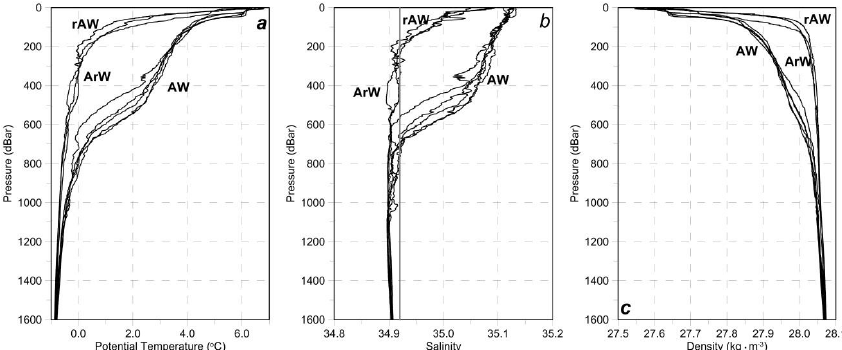
Figure 5. Profiles of (a) temperature, (b) salinity and (c) density from the both sides of the Arctic Front (AF). Summer 2009, section “N”. Atlantic Water is indicated by “AW”, return Atlantic Water by “rAW”, and Arctic Water by “ArW”. A vertical line indicating S = 34 . 92 has been added in the salinity scale.